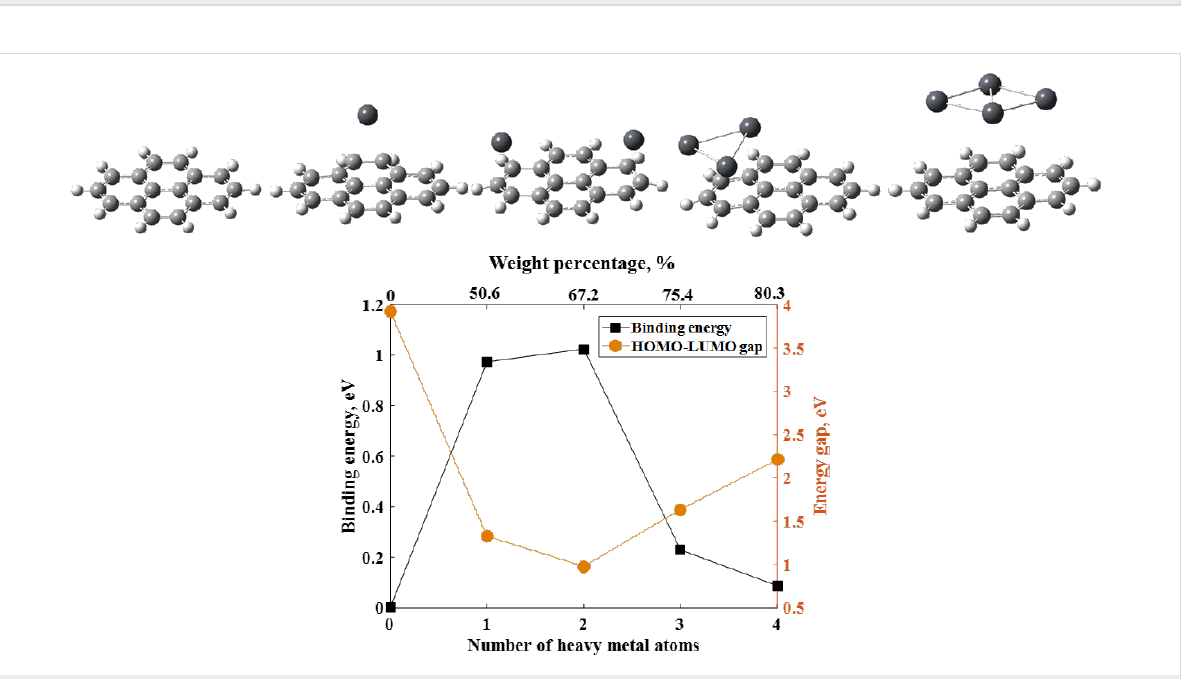
Figure 6: (a) Dependence of the binding energies of Cd and Hg on the number of heavy metal atoms on graphene flake. (b) Dependence of the HOMO–LUMO gap of graphene clusters interacting with Cd and Hg on the number of heavy metal atoms.